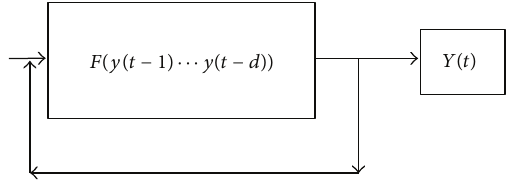
Figure 2: Design for input data generation.